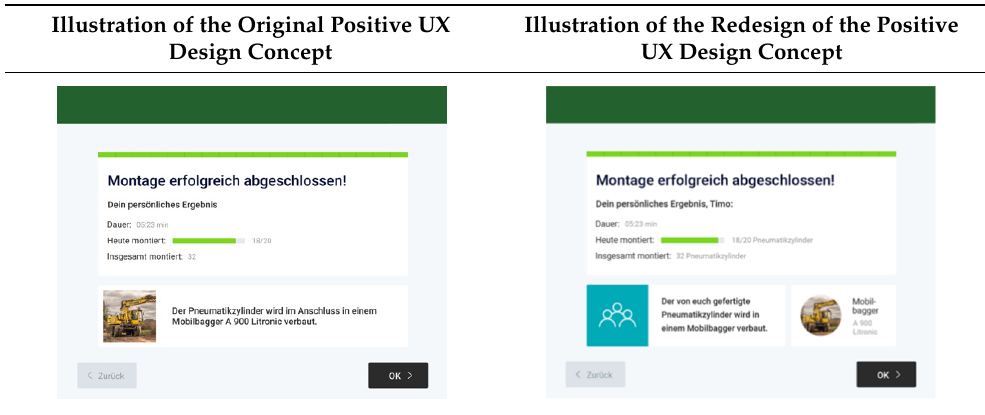
showing a group of three people on a blue background (see Table 9). Table 9. Original positive UX design concept and respective redesign of “Forecast to the final product”.